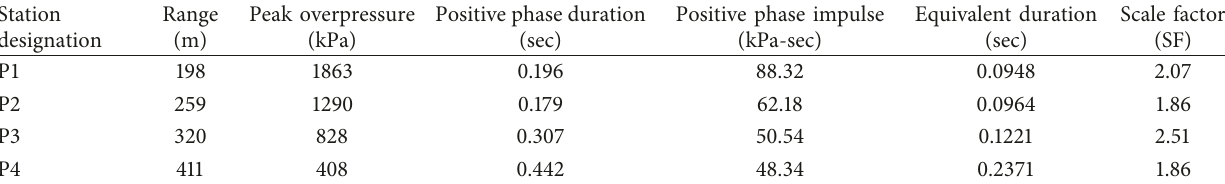
Table 2: Details of recording stations.